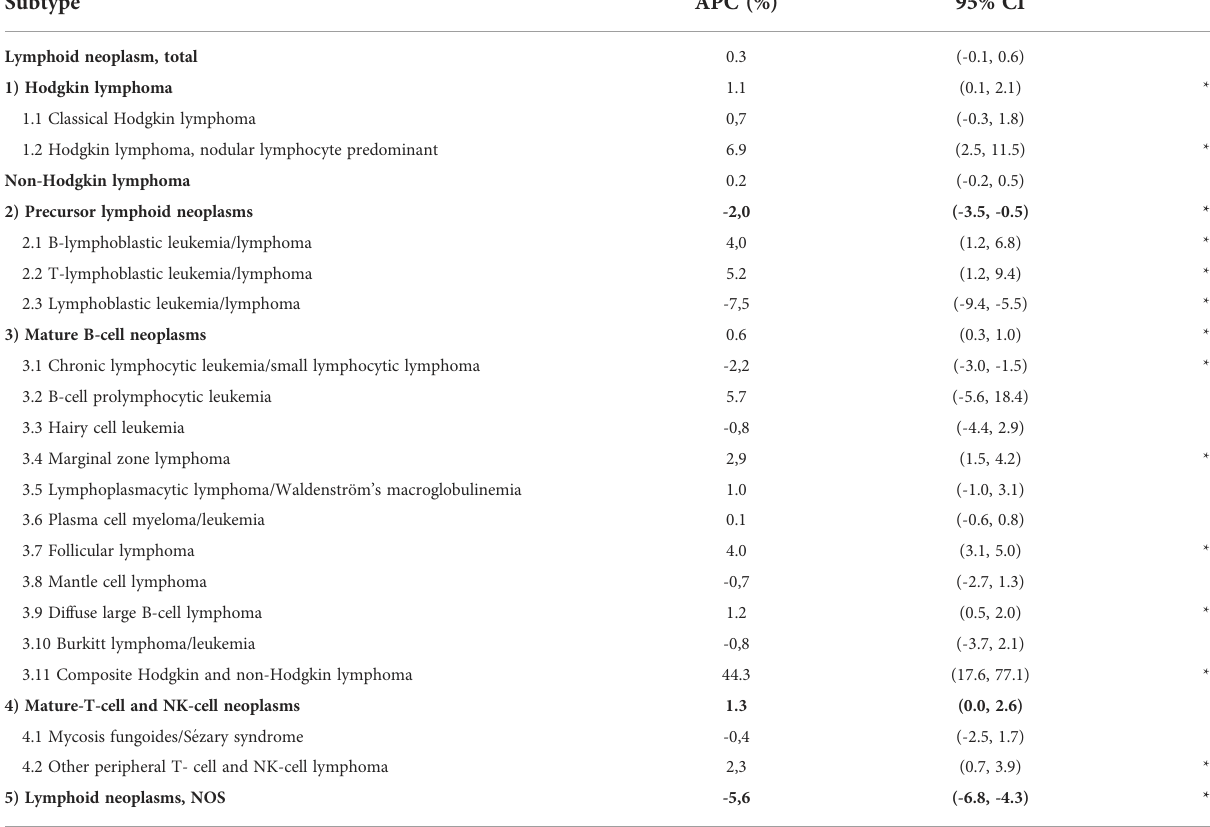
TABLE 2 Incidence trends of lymphoid neoplasms diagnosed in Spain, 2002-2013. Subtype Lymphoid neoplasm,